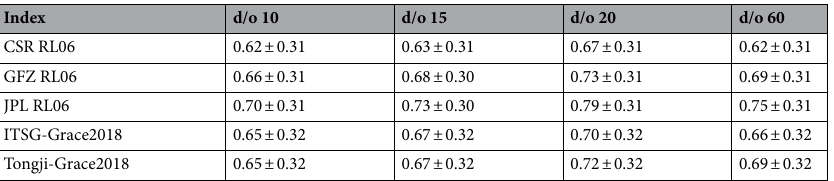
Table 9. The semi-annual amplitude of GMOM change for five GRACE solutions at different truncated degree and orders (d/o) from January 2005 to December 2016 except for the degree-1 and C 20 coefficients [unit: